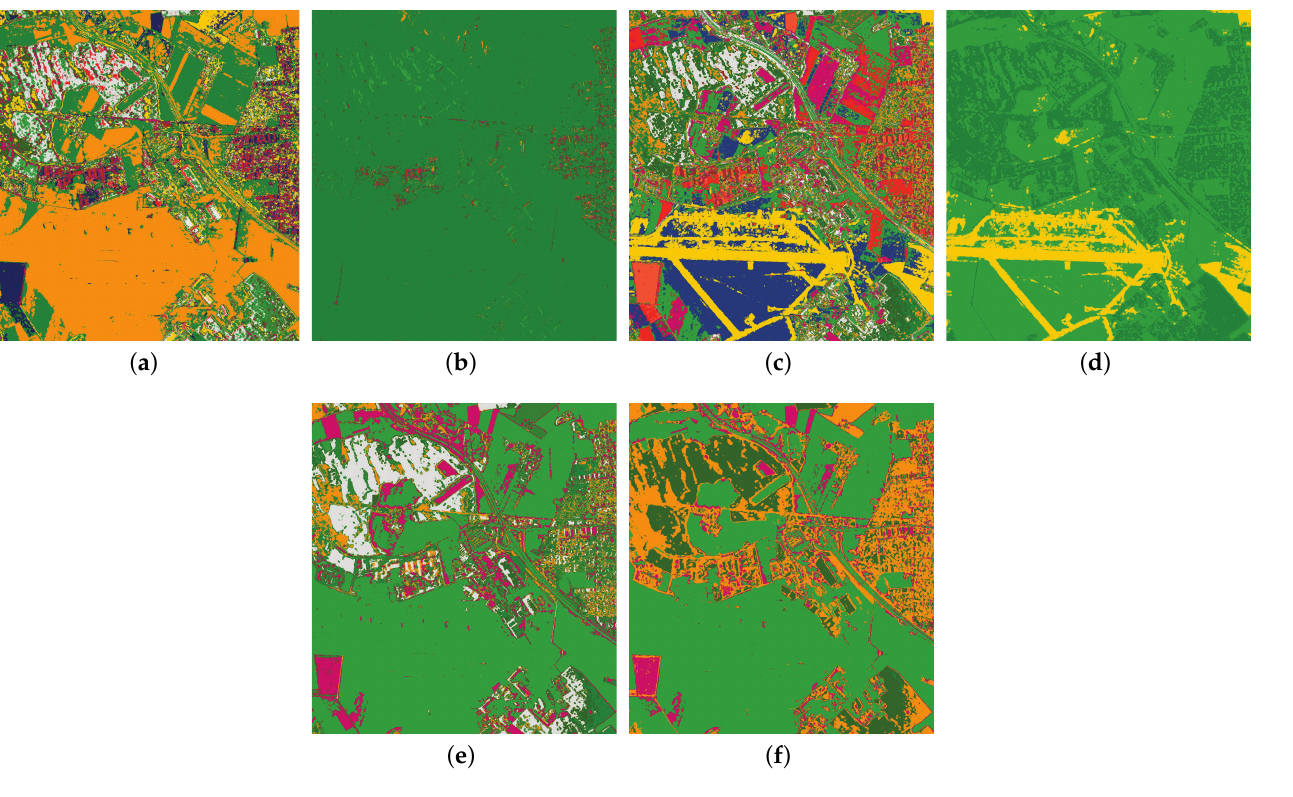
Figure A6. Classification results of different algorithms and class numbers. ( a ) Result of H / A / α - Wishart with 16 classes. ( b ) Result of H / A / α -Wishart with 5 classes. ( c ) Result of h / q / gray -Wishart with 16 classes. ( d ) Result of h / q / gray -Wishart with 5 classes. ( e ) Result of the proposed with 16 classes. ( f ) Result of the proposed with 5